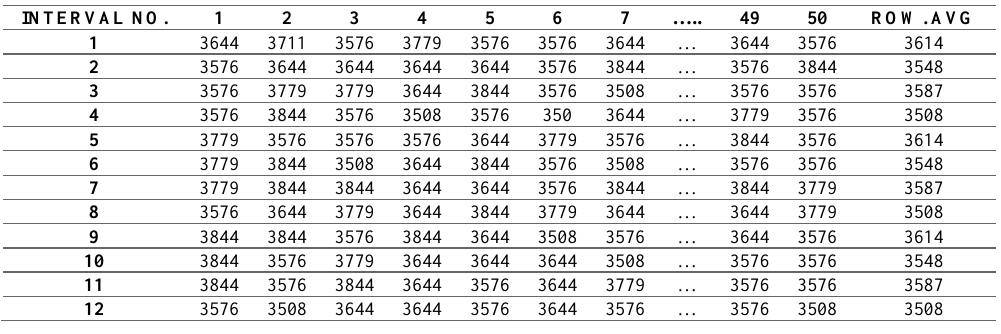
Table 10. Result of simulation with each